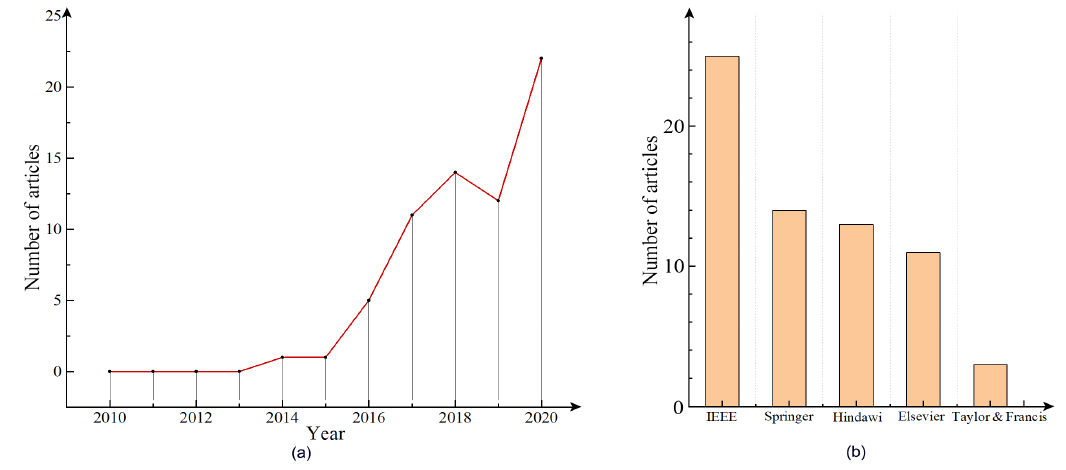
Fig. 6 Time trend publication and publisher wise